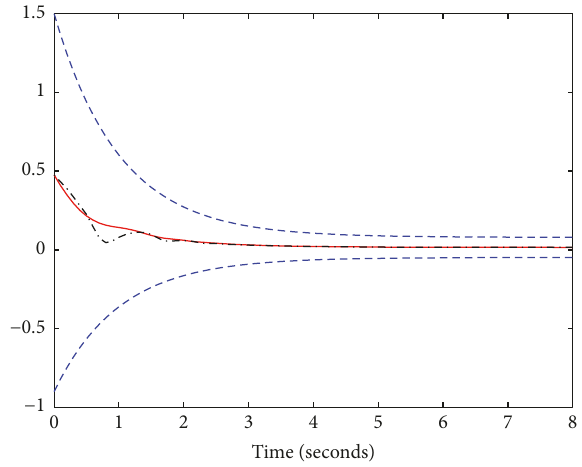
Figure 12: Angular position tracking error 𝑒 12 : neural learning control (—), ANC (- ⋅ - ⋅ ), and the error bounds (- - -).